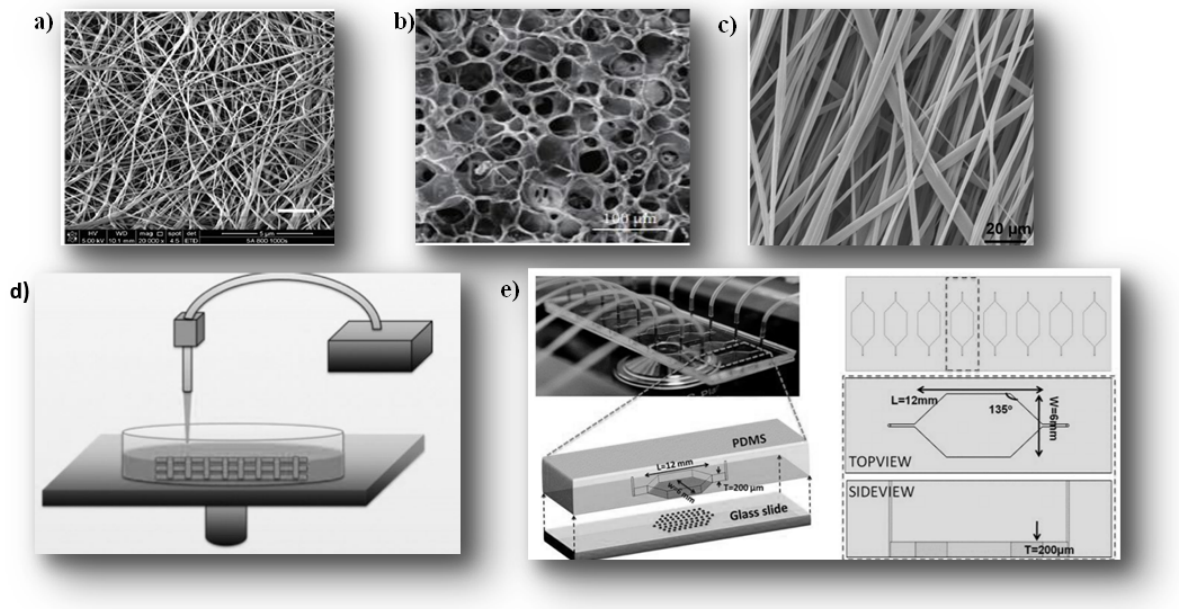
Figure 3. Different synthetic strategies of 3D matrix-based: ( a ) collagen; ( b ) Lyophilization; ( c ) Electrospiding; ( d ) Stere- olithography; ( e ) Micro fluid